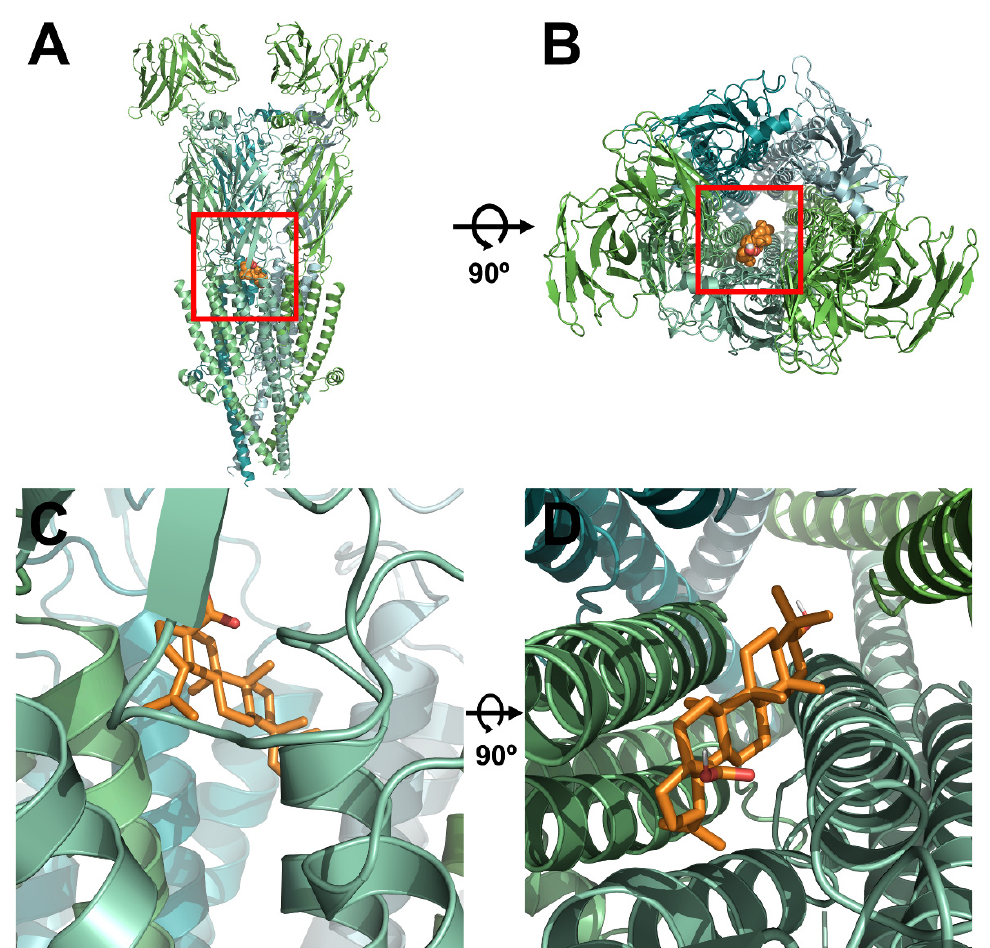
Figure 3. Molecular interaction of BA based on the docking model of α 3 β 4 nAChRs in 3D structure. ( A – D ) A view of the BA interaction site on α 3 β 4 nAChRs from the side and top. This structure was constructed based on the structure shown in the protein data bank (PDB) (ID